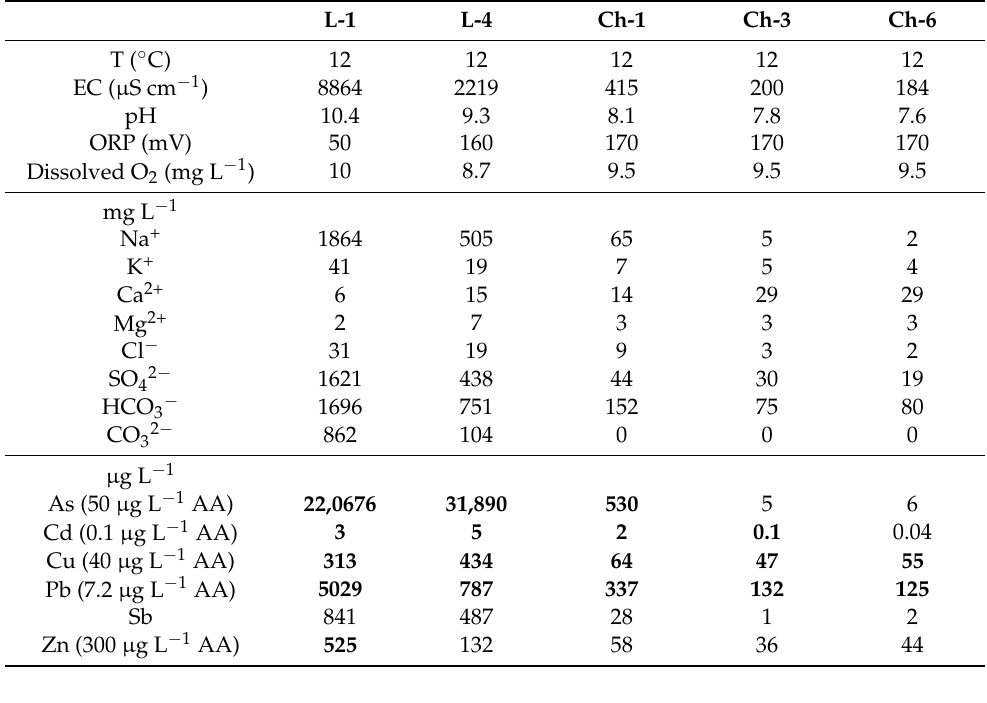
Table 4. Physicochemical characteristics of the surface waters. T, temperature; EC electrical conduc- tivity; ORP, oxidation–reduction potential. The maximum allowable annual average (AA) values for the selected elements are shown. Contents exceeding the AAs are bolded.